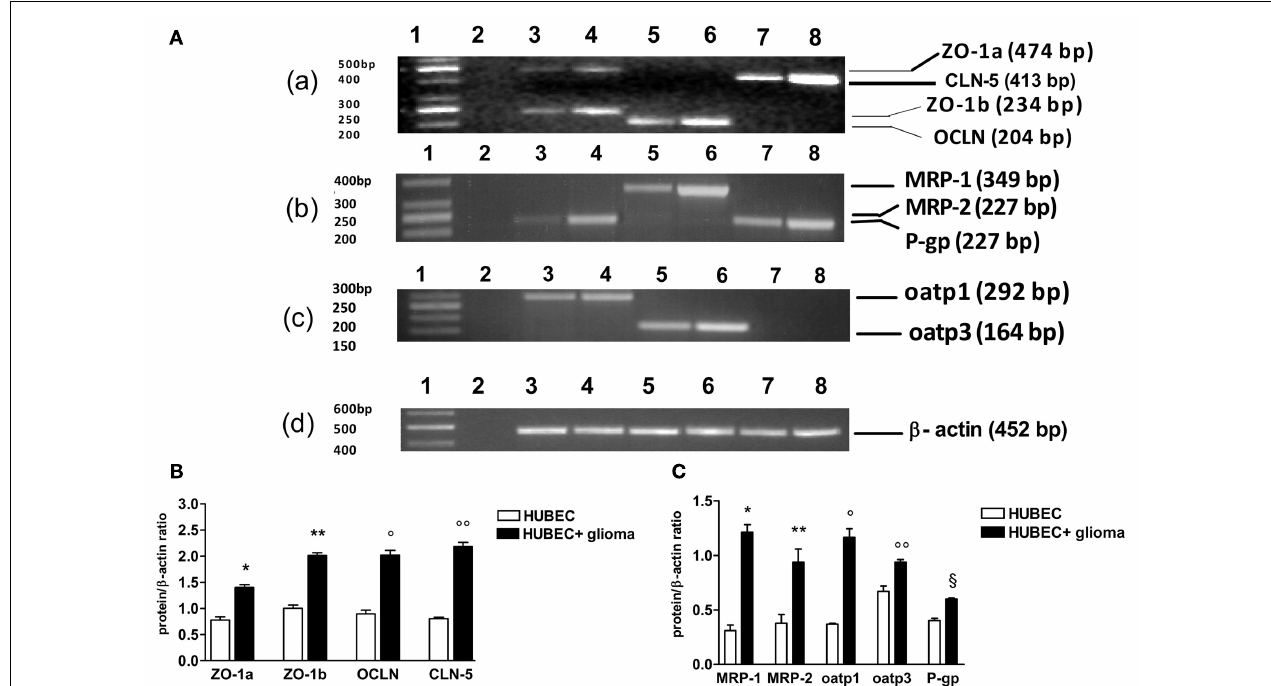
left, base pair (bp) size of the DNA ladder markers, on the right, bp size of the gene products. (B) Expression ratios of tight junction mRNA obtained dividing tight junction mRNA densitometric values by those of β -actin.The results are expressed as mean ± SEM of three independent cultures in the presence or absence of glioma cells from three different tumors listed in Table 1 ( n = 3). ∗ HUBEC vs HUBEC + glioma, p = 0.0017; ∗∗ HUBEC vs HUBEC + glioma, p = 0.009; °HUBEC vs HUBEC + glioma, p = 0.0003; °°HUBEC vs HUBEC + glioma, p = 0.0005 (paired t -test). (C) Expression ratios of drug transporter mRNA obtained dividing drug transporter mRNA densitometric values by those of β -actin.The results are expressed as mean ± SEM of three independent cultures in the presence or absence of glioma cells from three different tumors listed in Table 1 ( n = 3). ∗ HUBEC vs HUBEC + glioma, p = 0.006; ∗∗ HUBEC vs HUBEC + glioma, p = 0.025; °HUBEC vs HUBEC + glioma, p = 0.0097; °°HUBEC vs HUBEC + glioma, p = 0.014; § HUBEC vs HUBEC + glioma, p = 0.0073 (paired t -test). ZO-1, zonula occludens; OCLN, occludin; CLN-5, claudin-5; P-gp, P-glycoprotein; MRP-1, multidrug resistance protein-1; MRP-2, multidrug resistance protein-2; oatp1, organic anion-transporting polypeptide-1; oatp3, organic anion-transporting